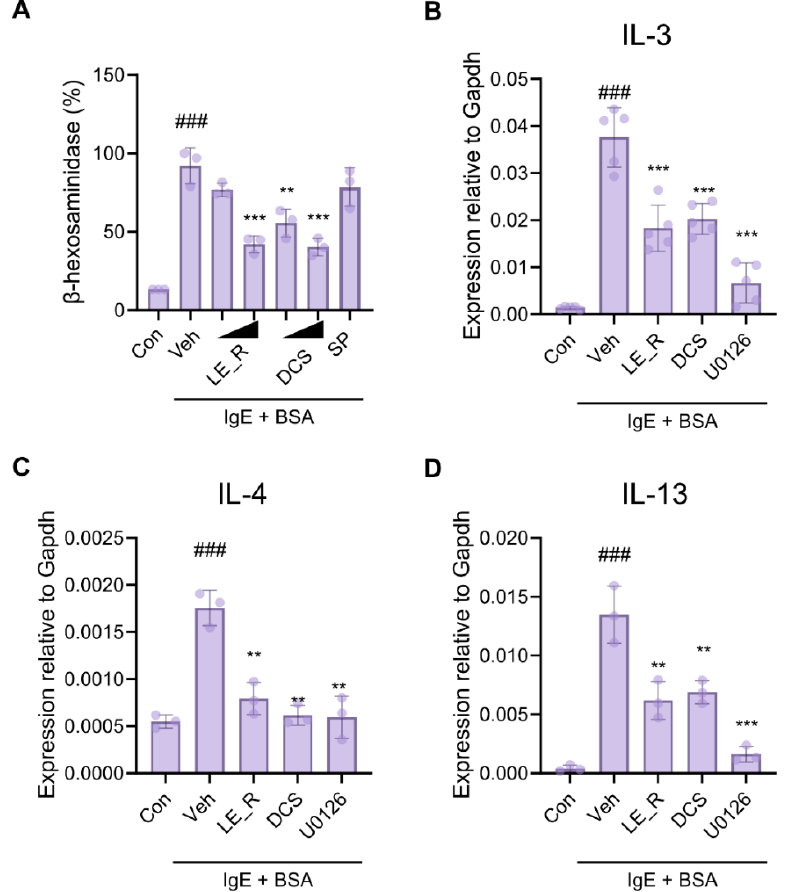
Figure 8. N,N (cid:48) -dicoumaroylspermidine exhibits antiallergic effects by inhibiting degranulation and cytokine expression by RBL-2H3 cells. Fc ε RI-mediated release of β -hexosaminidase and cytokine expression. ( A ) RBL-2H3 cells were sensitized with anti-DNP-IgE and treated with LE_R (50 µ g/mL), DCS (10, 50 µ M), or SP (50 µ M) for 1 h, and then challenged with DNP-BSA. Release of β -hexosaminidase was detected after stimulation with DNP-BSA. ( B – D ) RBL-2H3 cells were sensitized with anti-DNP-IgE and treated with LE_R (50 µ g/mL), DCS (50 µ M), or U0126 (10 µ M) for 1 h, and then challenged with DNP-BSA. Expression of mRNA encoding IL-3 ( B ), IL-4 ( C ), and IL-13 ( D ) was determined by real-time RT-PCR. Data are expressed as the mean ± SD. ### p < 0.001 versus the Control group. ** p < 0.01, *** p < 0.001 versus the Vehicle group. Con, control; Veh, vehicle; LE_R, reflux ethanol extract of L. erythrorhizon ; DCS, N,N (cid:48) -dicoumaroylspermidine; SP,